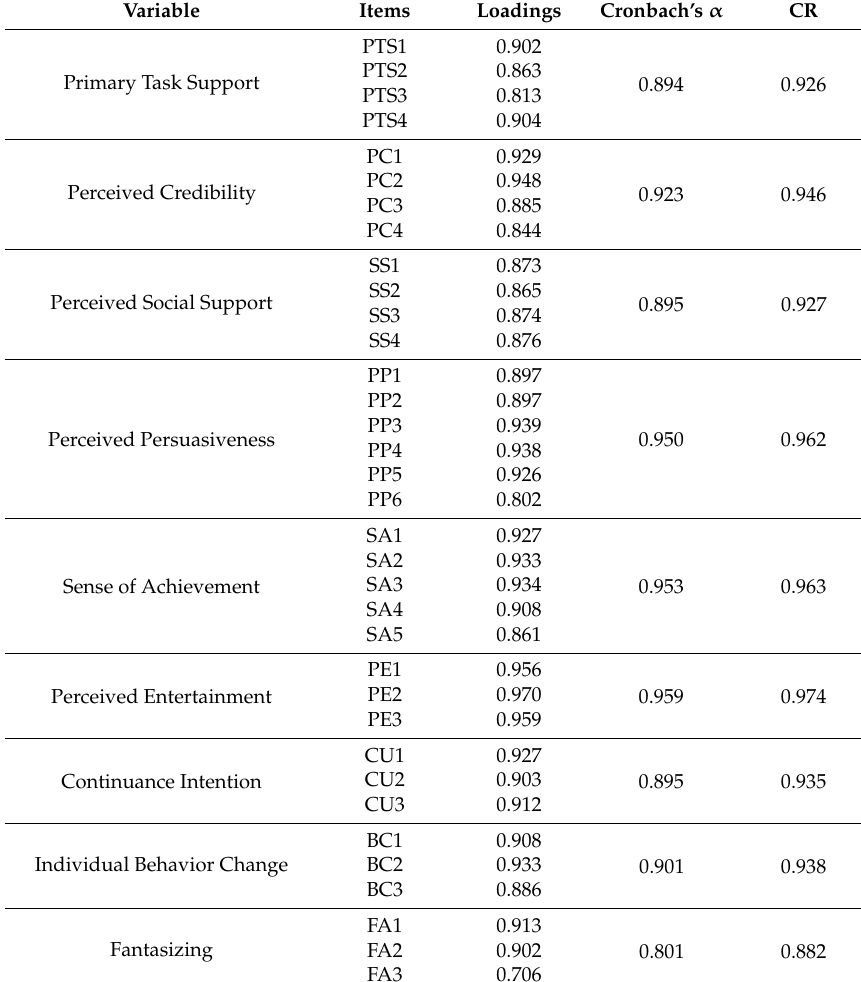
Table 3. Reliability and Composite Reliability